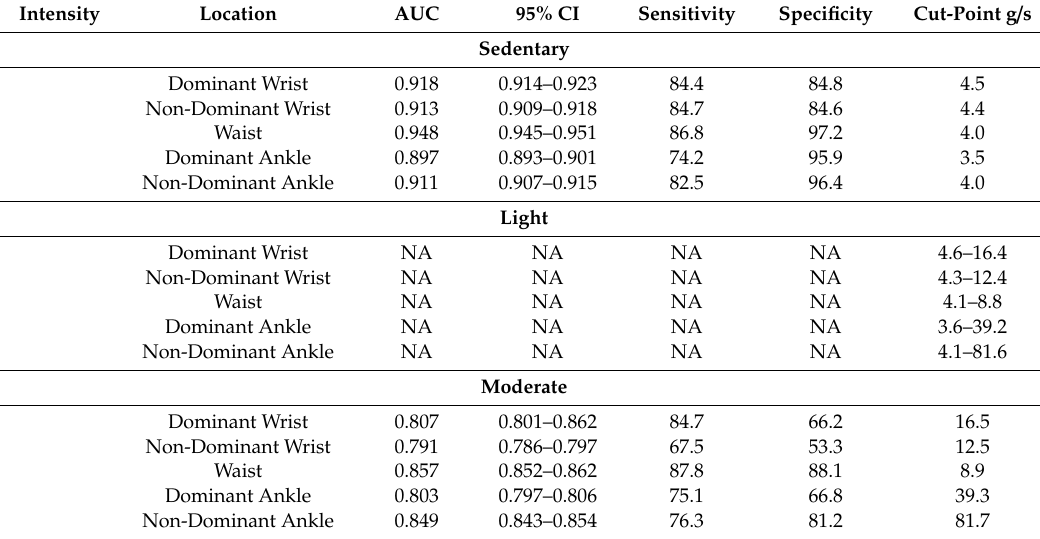
Table 1. Area under the curve (AUC), sensitivity (%) and specificity (%) and resultant cut-points for each GENEActiv monitor with METs.